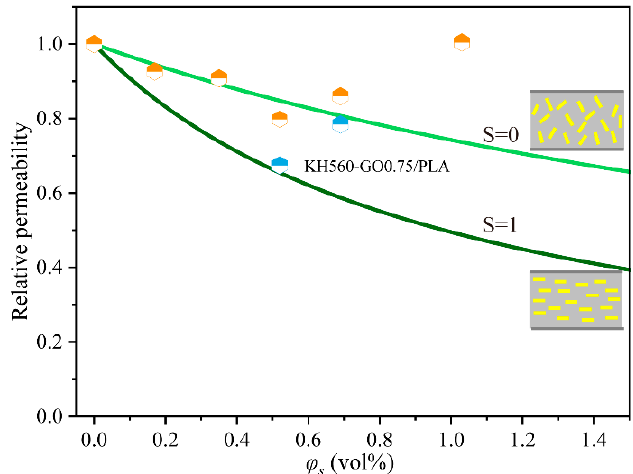
Figure 6. Experimental data about P O2 and the Bharadwaj model for the relative permeability in terms of GO and KH560-GO loadings are compared (the yellow symbols refer to GO/PLA and the blue symbols refer to KH560-GO/PLA).